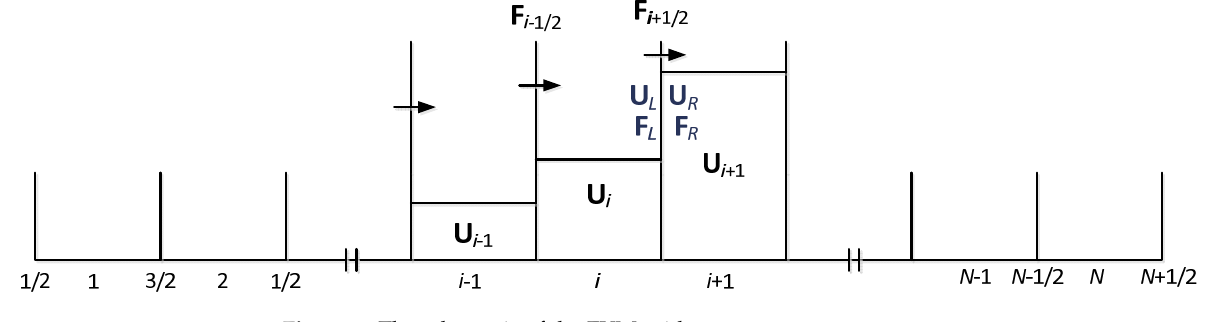
Figure 2. the schematic of the FVM grids. Figure 2. The schematic of the FVM